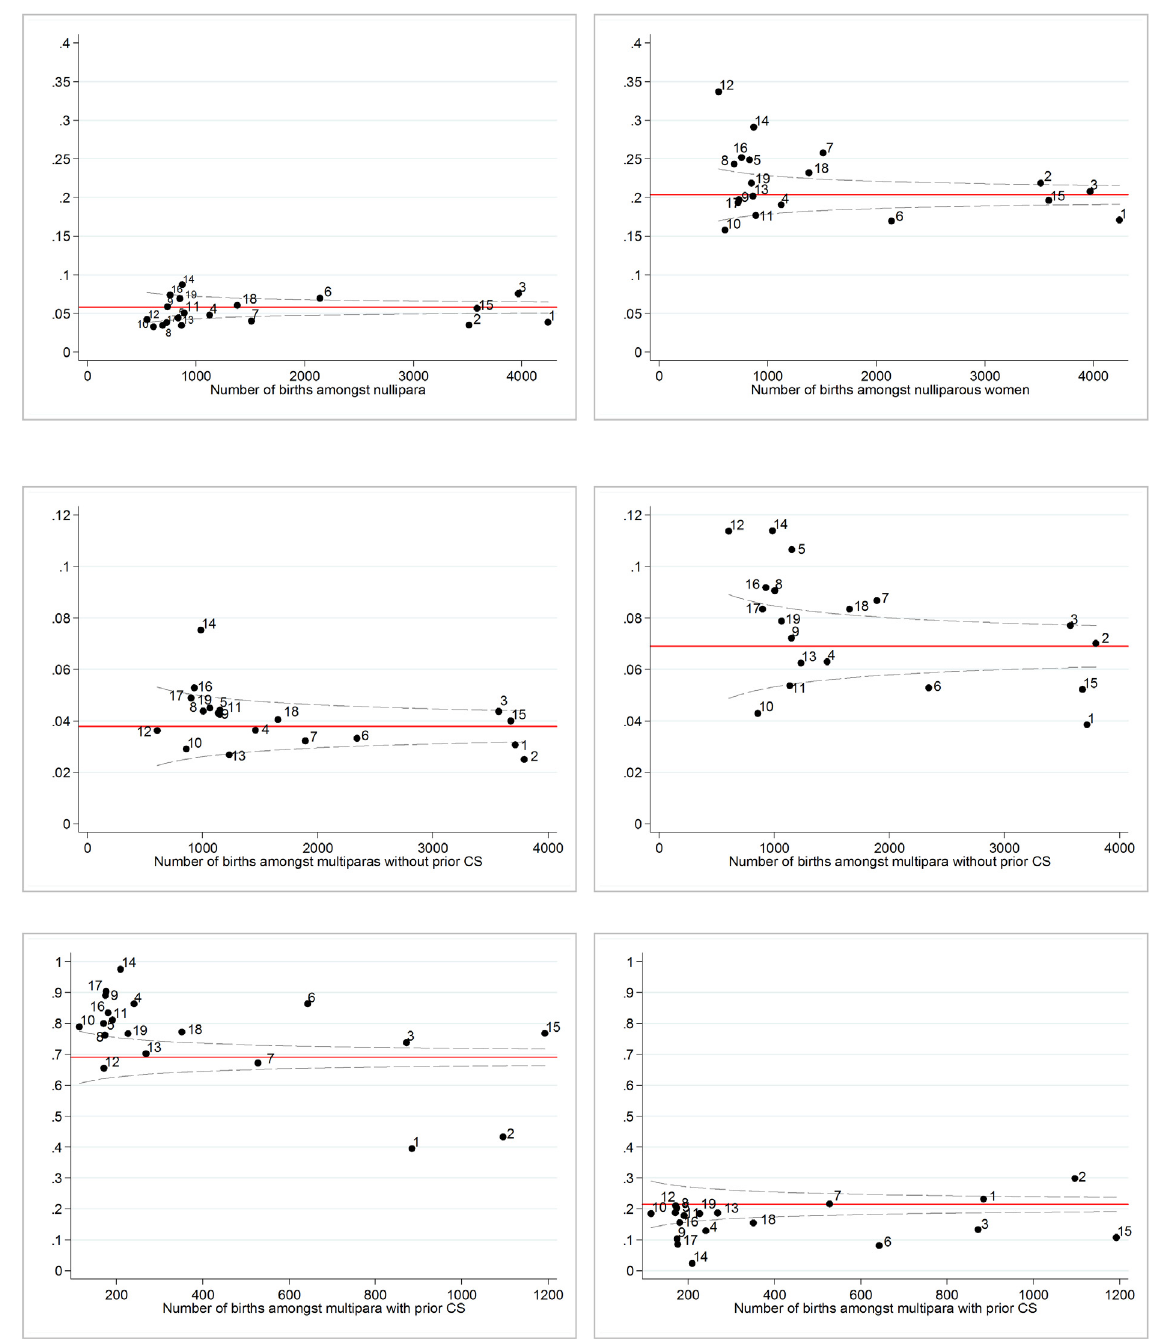
Fig 1. Unadjusted variation between hospitals for elective CS and emergency section. CS- caesarean section. Unadjusted rates. Left panel contains data for elective CS. Right panel contains data for emergency CS.